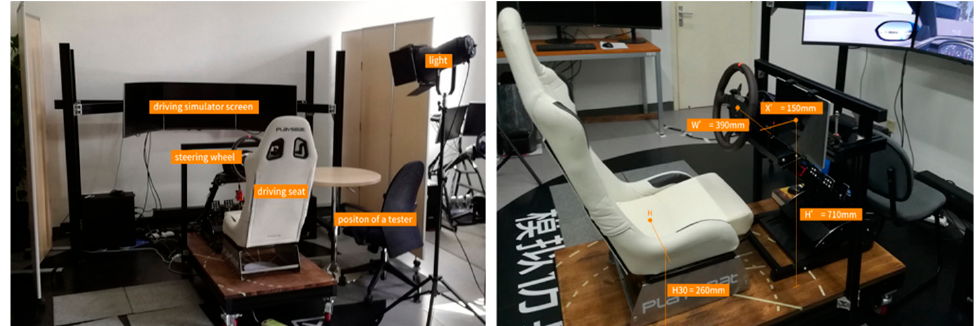
Figure 1. Test environment and test site.